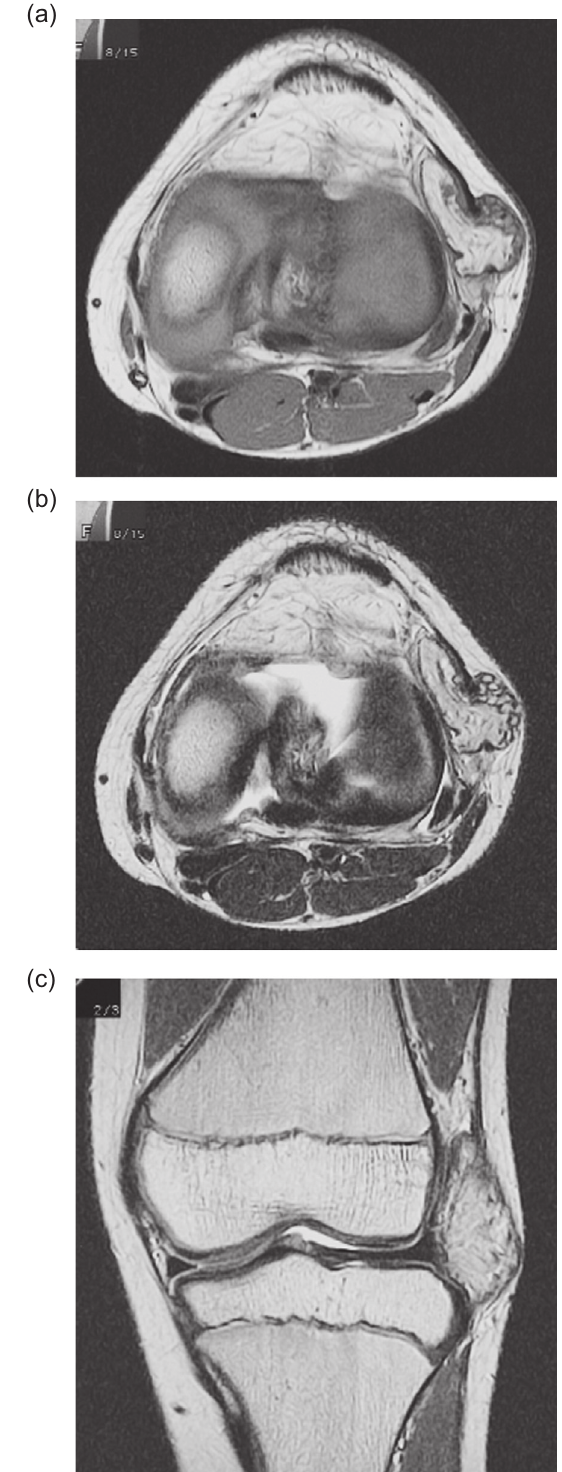
Figure 2. MRI of the tumor demonstrated a high signal intensity area on the T1-weighted image in the axial (a) and T2-weighted image in the axial and coronal views (b, c), and heterogeneously, a low signal intensity area was seen in the tumor. The tumor was located in the extra-capsular lesion of the lateral knee joint and had a diameter of 4